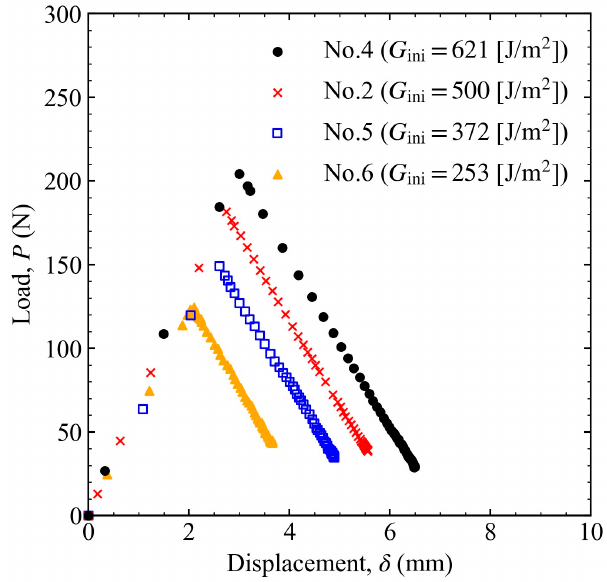
Figure 7. Relationship between the load and displacement when the initial load level was changed to 621, 500, 372, and 253 J/m 2